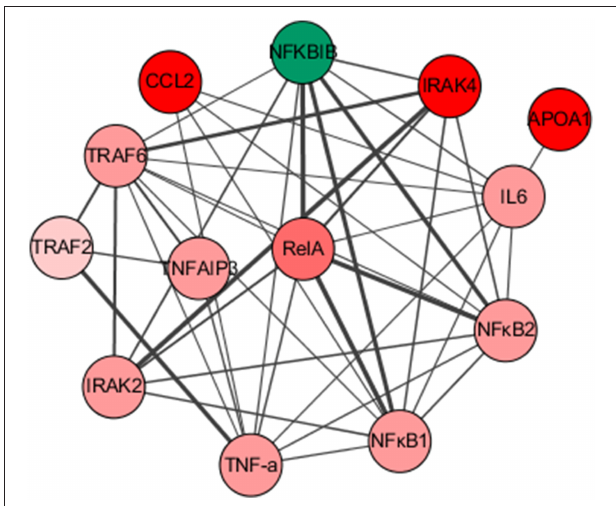
FIGURE 4 | Network Analysis of the DEPs involved in immune response process. Significantly up-regulation and down-regulation proteins are represented in red and green, respectively. Varying magnitudes of the protein expression change are indicated in the color depth. The lines with different thicknesses showed the molecular relationships with different